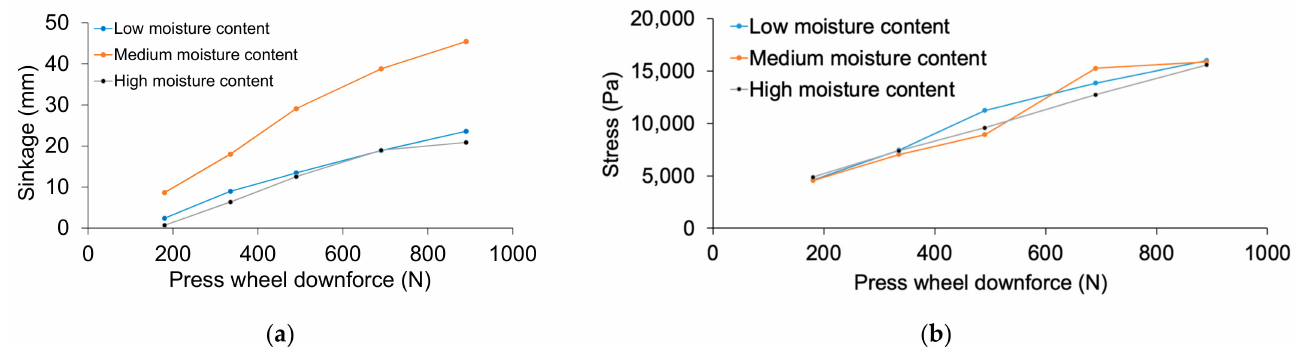
Figure 8. ( a ) Sinkage results for different down forces of press-wheel under different soil moisture levels; ( b ) soil stress versus press-wheel down forces under different soil moisture